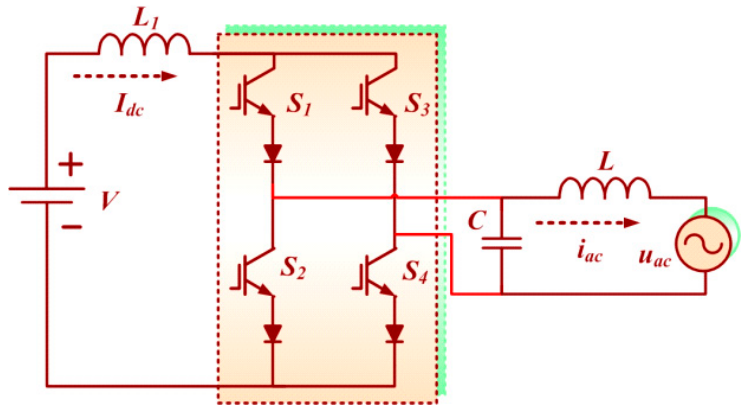
Figure 1. Basic single-phase current source converter.